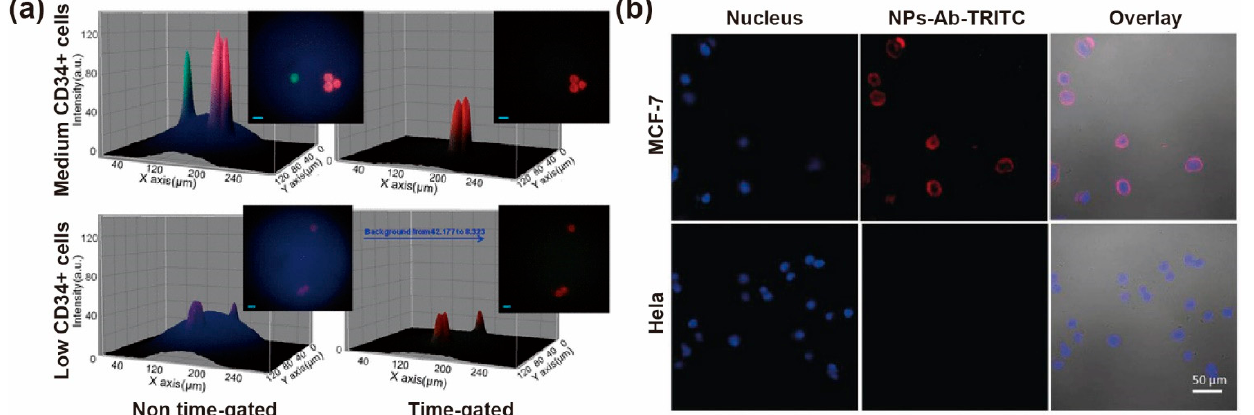
Figure 10. ( a ) The comparison of conventional UV fluorescence microscopy imaging (left) and time- gated luminescence microscopy imaging (right) of medium. Reproduced with permission from [84].